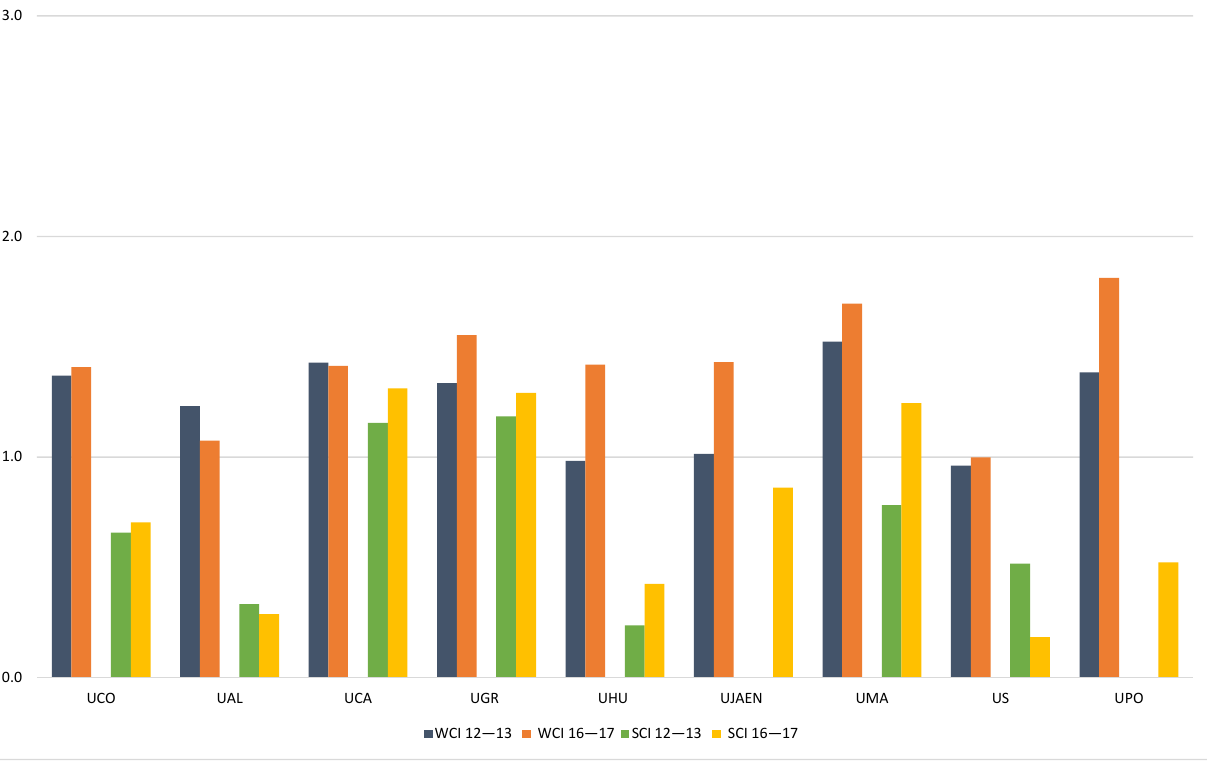
Figure 3. Evolution in the teaching mission of the Andalusian public university system from 2012–2013 to